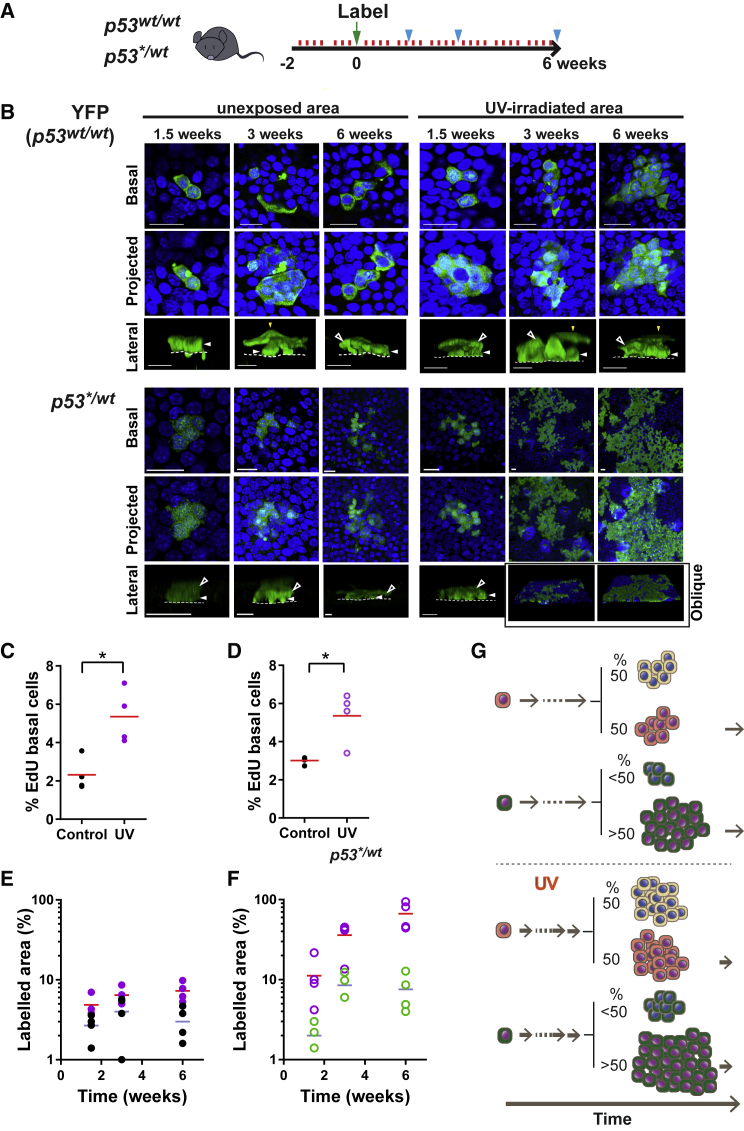
Short-Term Low-Dose UV Exposure Accelerates p53∗/wt Colonization(A) Protocol: AhcreERT-p53∗/wt or -RYFP mice were exposed to a sub-erythema dose of UVB daily, 4 days per week for 2 weeks (red lines), after which labeling was induced (green arrow) and UV exposure continued; sample collection is indicated by blue arrows.(B) Rendered confocal z stacks showing representative clones in epidermal whole mounts. Green indicates YFP in YFP panels and GFP in p53∗/wt panels; blue, DAPI. Scale bars, 20 μm. Basal, immediate suprabasal cells and basement membrane are indicated by closed and open arrows and dotted line, respectively.(C and D) Average percentage of EdU-labeled basal cells at the 6-week time point in induced AhcreERT-p53∗/wt (D) or AhcreERT-RYFP (C) IFE. Samples were taken from UV-irradiated (purple circles) or adjacent unexposed areas (ctl, black circles). Values are mean from 5 fields per mouse. Red line indicates mean. n = 4 mice per condition. ∗p < 0.05 by paired t test. Percentage EdU in UV-irradiated epidermis in (D) was quantified in p53∗/wt clone area.(E and F) Projected area of labeled UV irradiated and adjacent unirradiated IFE. Values are percentage from 6 fields. n = 4 mice per time point. (E) RYFP (purple, UV; black, unirradiated). (F) p53∗/wt (purple, UV; green, unirradiated).(G) Schematic illustration of the effect of UV on clone behavior. UV increases the rate of cell division in both p53wt/wt and p53∗/wt cells but accelerates IFE colonization by mutant cells as p53∗/wt progenitors retain a bias in fate, generating more progenitor than differentiating daughters.See also Figure S7 and Tables S5 and S7.